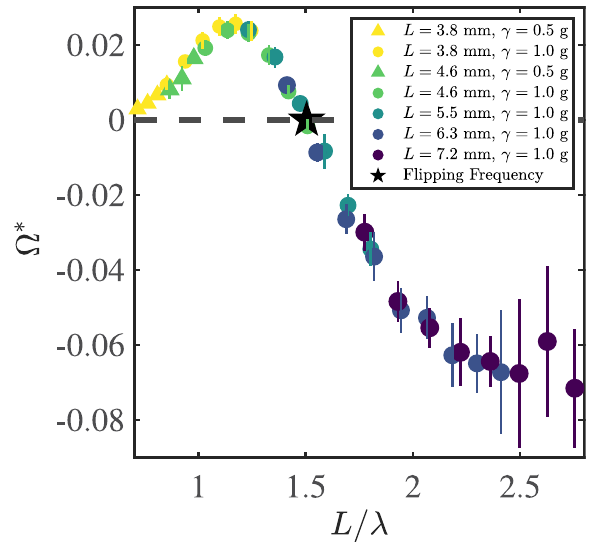
Fig. 3 The dimensionless angular velocity as a function of the dimensionless spinner size. The data from spinners for different combinations of wavelengths ( λ ), forcing amplitudes ( γ ), and sizes ( L ) all collapse along a non-monotonic curve F ( L / λ ). The fl ipping frequency (star) occurs at L / λ ≈ 1.5. The error bars represent one standard deviation in Ω * , which result from standard multivariate error propagation, using uncertainties in the angular velocity and fl uid parameters described in